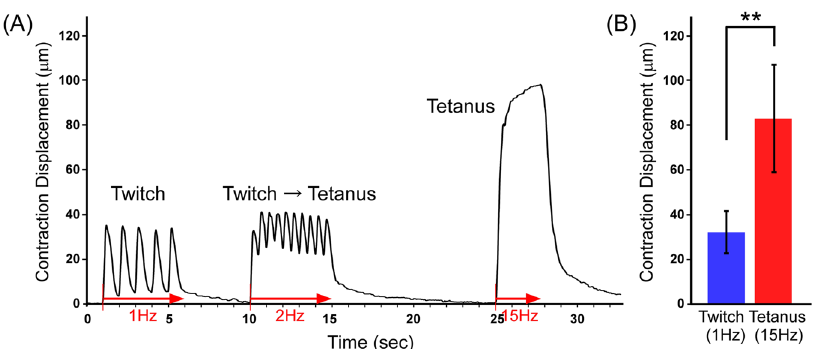
Figure 2. ( A ) Representative displacement profile of a myofiber sheet stimulated electrically at various frequencies (1, 2, and 15 Hz). This profile shows that the myofiber sheets showed a twitch contraction at 1 Hz and the contraction was partially fused at 2 Hz. At 15 Hz, myofibers shortened more dynamically (approx. 100 μ m) due to the tetanic contraction. The arrows indicate the time period of EPS application at 1, 2, and 15 Hz. ( B ) Displacement of twitch and tetanic contractions at frequencies of 1 Hz and 15 Hz, respectively. (n = 3) ( ** P <